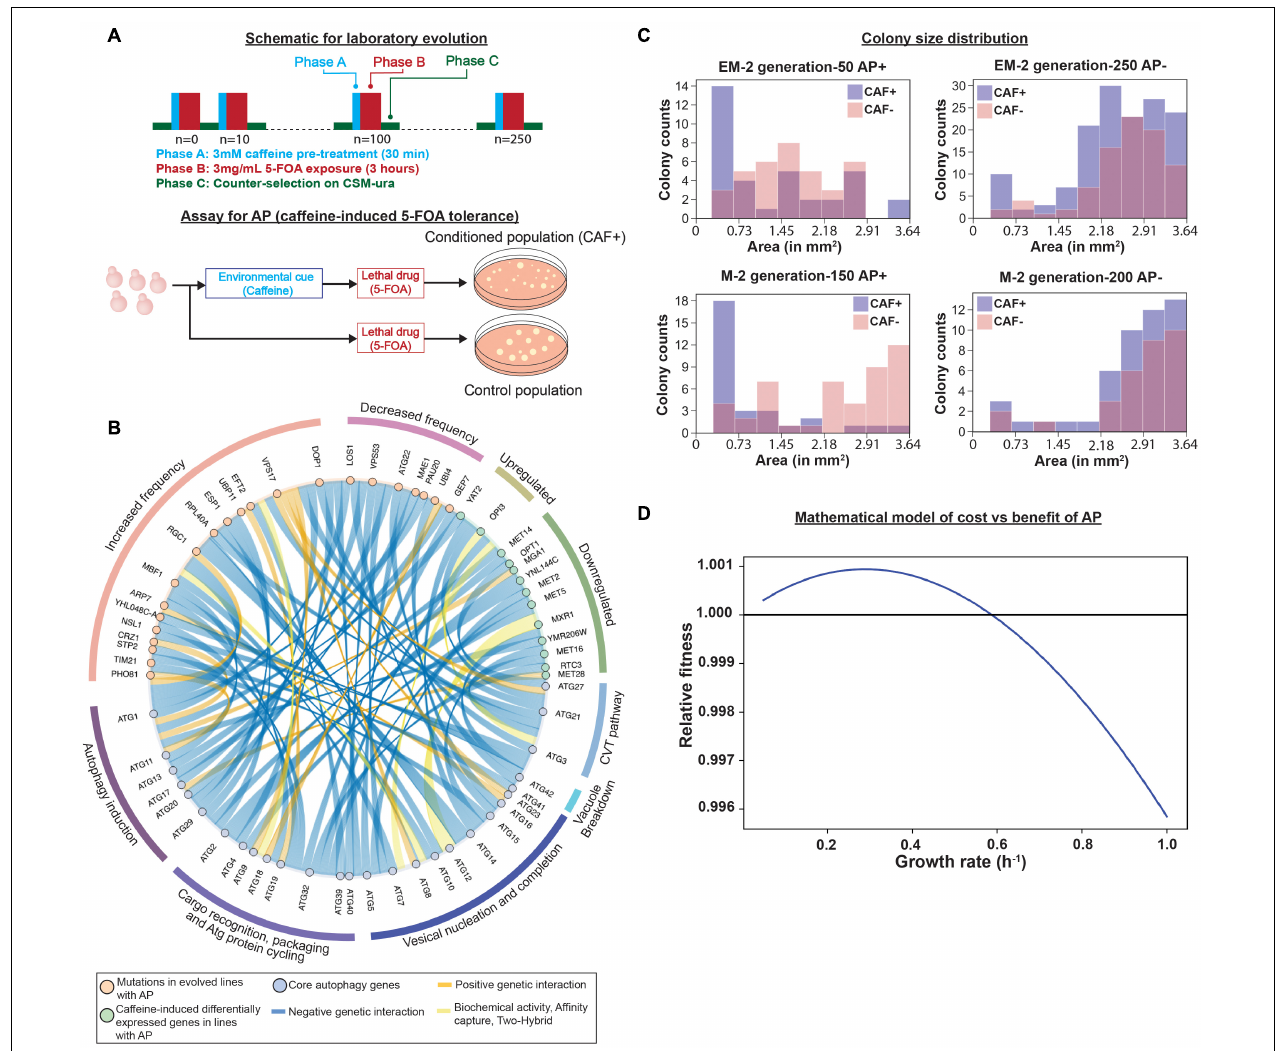
FIGURE 1 | Regulation of emergence of adaptive prediction (AP) during laboratory evolution. (A) Experiment design for laboratory evolution of caffeine-induced AP of increased conditional fitness to 5-FOA. (adapted from our previous work de Lomana et al., 2017). (B) Genes with increased or decreased mutation frequency or perturbed regulation in evolved lines with AP interact genetically, physically, or biochemically with core autophagy genes (re-analysis of data previously published in de Lomana et al., 2017). (C) Distribution of colony sizes in EM2 (engineered line that was UV-mutagenized) and M2 (parental strain- BY4741-URA3 that was UV-mutagenized) evolved lines. EM2 line exhibited AP from generation 50 to 200 and AP was lost at generation 250. M2 line gained AP by generation 100, retained AP through generation 150, and ultimately lost it by generation 200. Colony size distribution indicates presence of smaller sized colonies in caffeine-treated (CAF + ) cultures of evolved lines with AP (AP + , EM2: generation 50; and M2: generation 150) or without AP (AP − ; EM2: generation 250; and M2: generation 200), as indicated in the header of each plot. Colony sizes were measured using Image J (Weka segmentation) and pixel area was converted to mm 2 based on total pixel area of the entire plate. (D) Relationship between growth rate and relative fitness inferred by a mathematical model of cost vs. benefit of